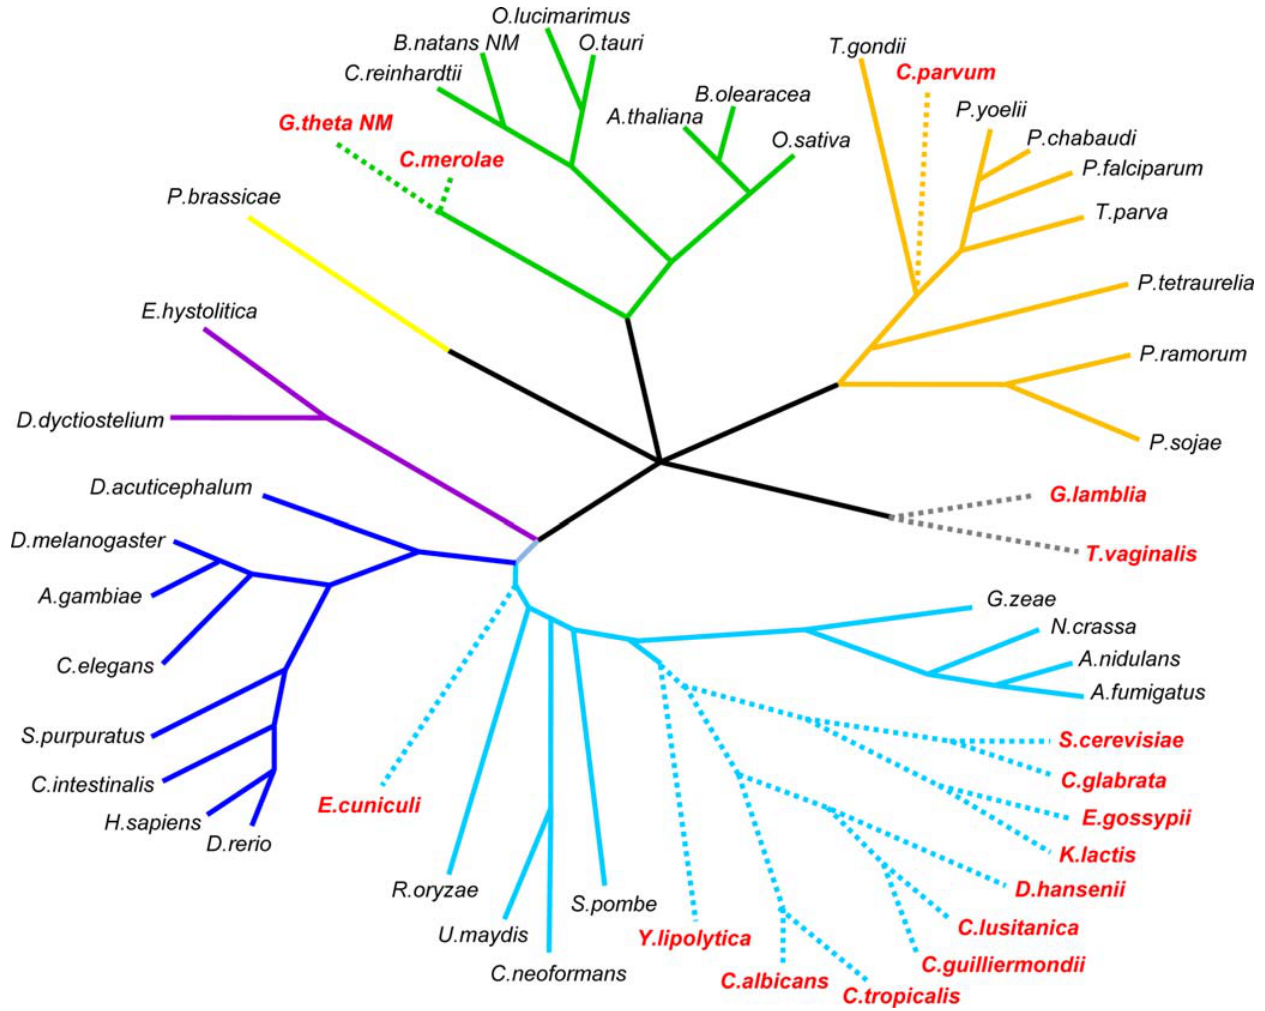
Figure 2. Phylogenetic relationship between the species included in this study. Consensus phylogenetic tree of the species included in this study. Red species names and discontinuous branches indicate intron-poor species. Note that representatives of all eukaryotic supergroups have been included in this study. Based on [47,48].